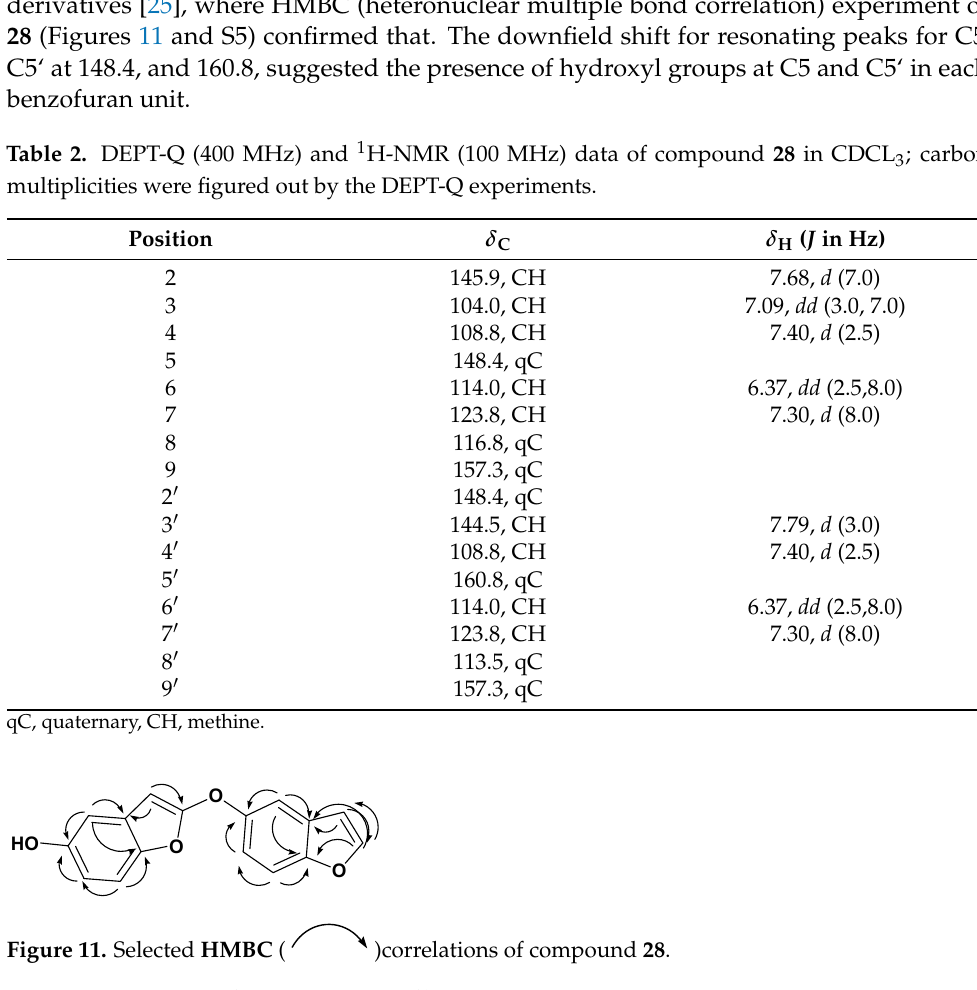
Table 3. Interaction binding energies (S; kcal/mol) and binding accuracy (RMSD; Å) of isolated com- pounds from V. vinifera seeds and co-crystallized ligand within TNF α active site (PDB ID: 2AZ5).